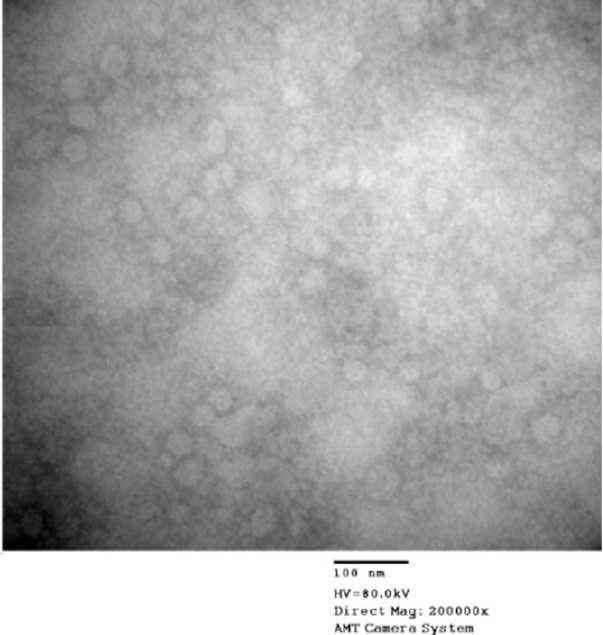
Figure 2. Morphology of virus-like particles (VLPs) as shown in transmission electron microscopy (TEM). Drawn to scale: 100 nm. Detected protein as seen in Figure 1b was purified by PEG precipitation using 7% PEG 6000 solution and 2% NaCl solution to verify presence of PiCV VLPs. Purified VLPs were used to coat a slotted carbon grid and stained with phosphotungstic acid (PTA) before viewing under transmission electron microscope (TEM).